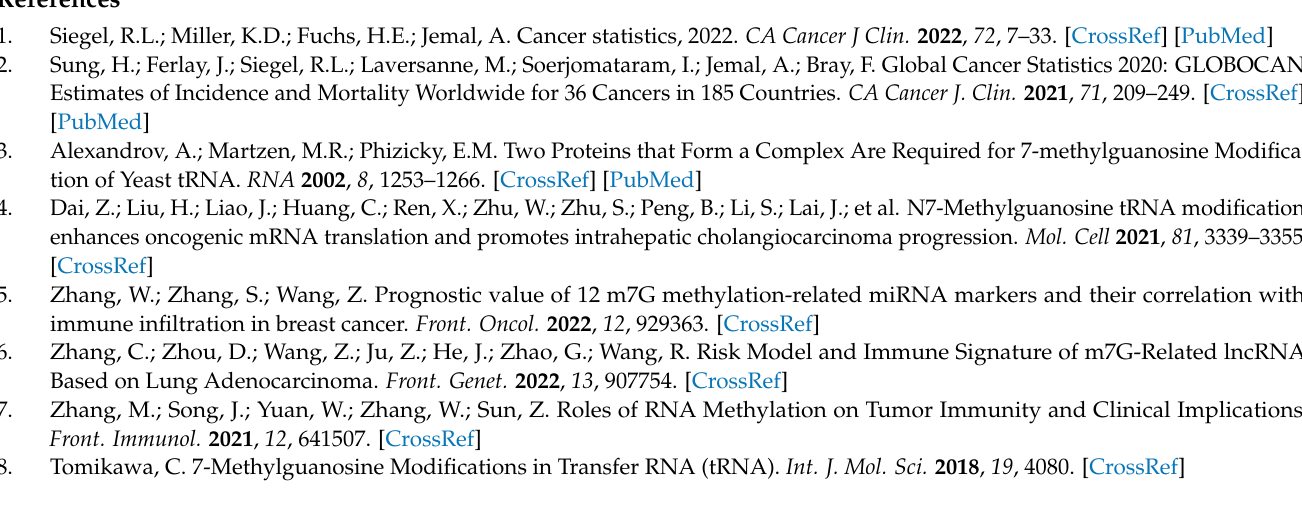
Table S1: List of 29 m7G-related genes; Table S2: List of intersecting genes among different m7G clusters; Table S3: List of 211 prognostic DEGs among different m7G clusters; Table S4: List of 15 prognosis-associated m7G genes; Table S5: Primers of m7G-related genes utilized for qPCR in this